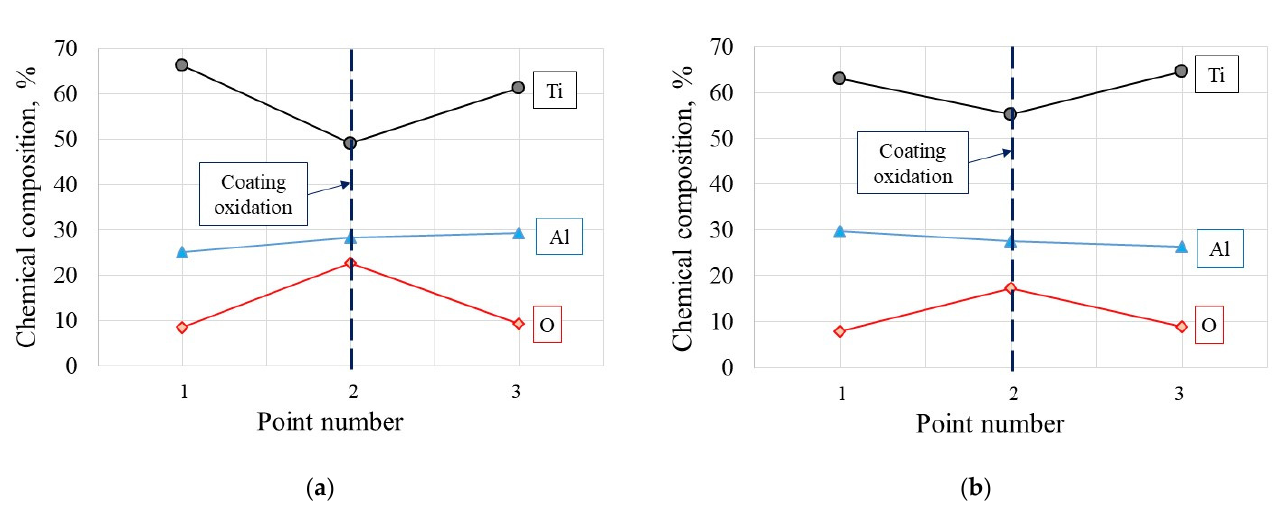
Figure 11. Average semi-quantitative chemical composition detected in points 1, 2 and 3 at the flank faces in Figures 8b and 9b after machining of IN718 ( a ) and Ti6-4 ( b ) alloys with the cutting speed of 200 m/min; machining time of 30 s (data specified in Table 5).